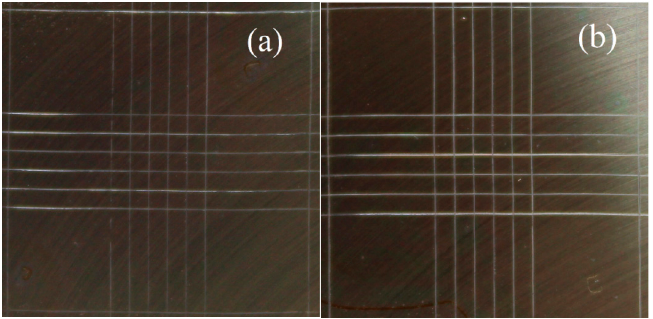
Figure A3. The full FTIR spectra for beech coatings ( a ) and spruce coatings ( b ).